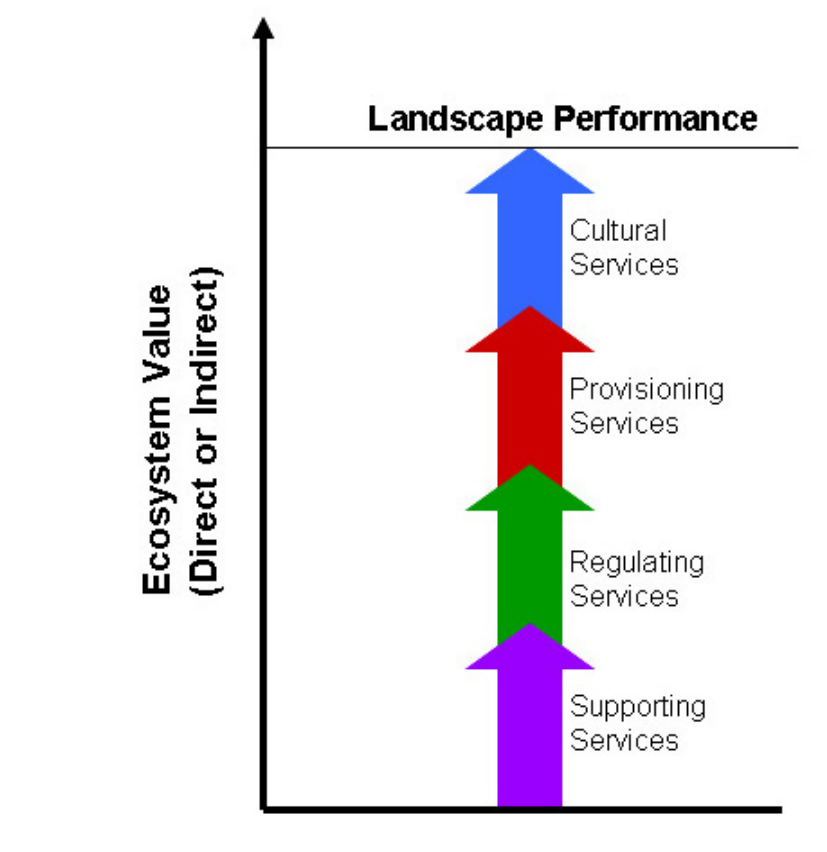
Figure 8. Conceptual diagram of the landscape performance